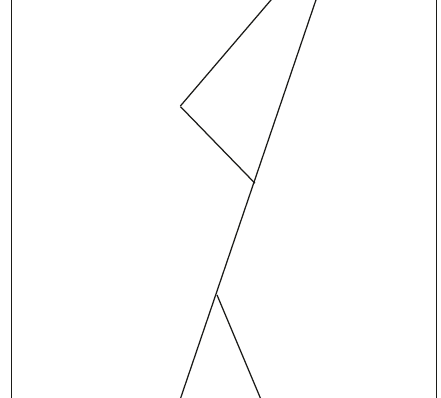
Figure 6: A simple fracture network.